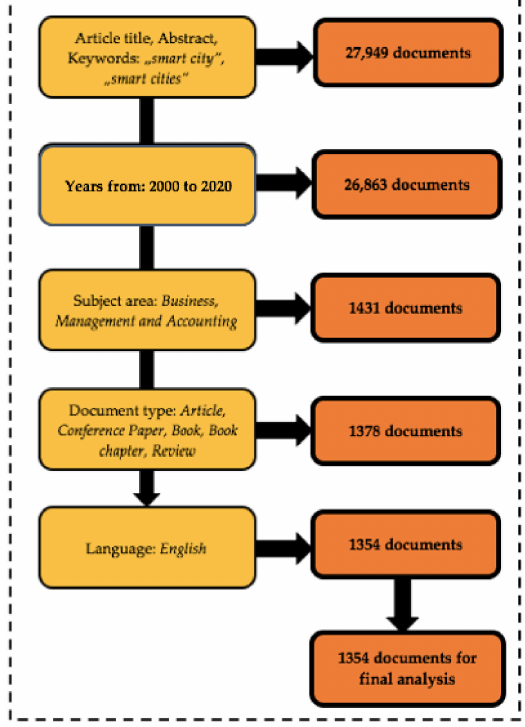
Figure 1. The document selection process scheme.